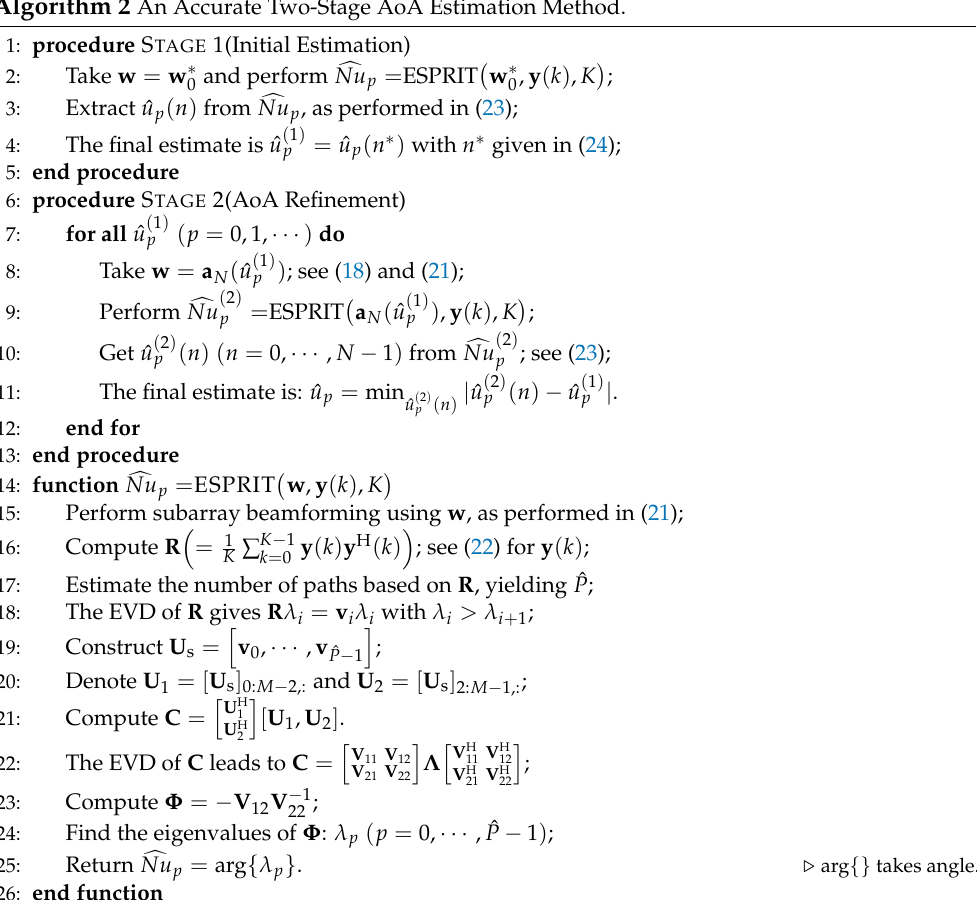
Algorithm 2 An Accurate Two-Stage AoA Estimation